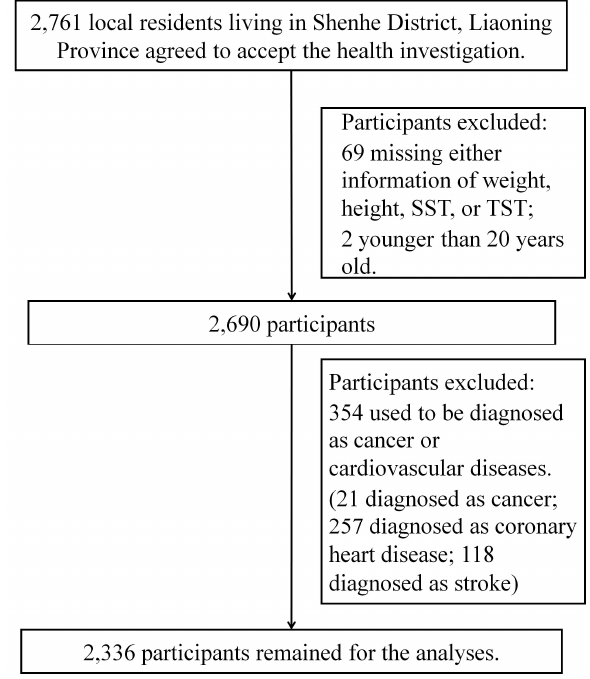
Figure 1. Flowchart for the Present Study.